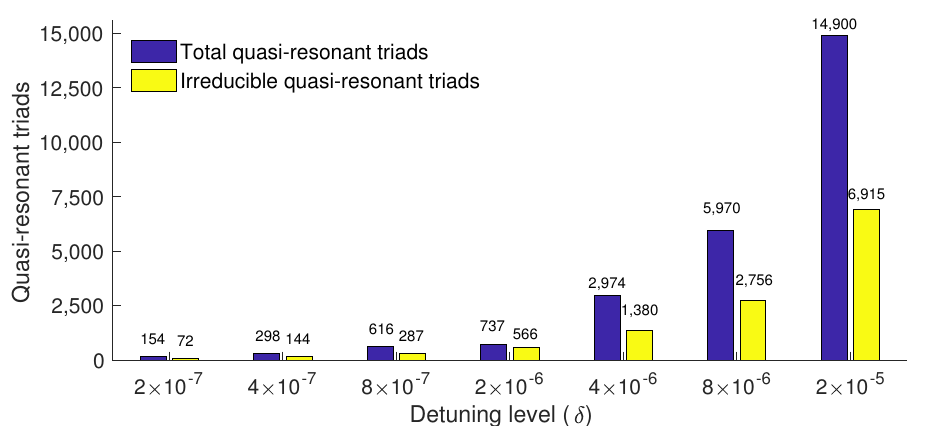
Figure 2. Bar graph of quasi-resonant triads in terms of detuning levels, for aspect ratio f = 1 and box size L =